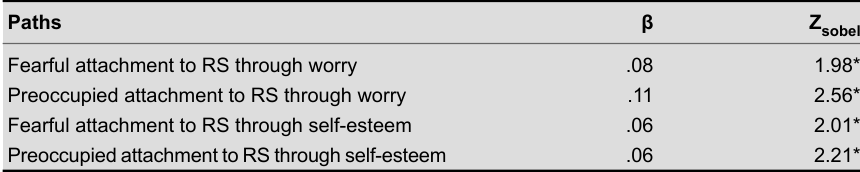
Standardized Indirect Effects on Rejection Sensitivity